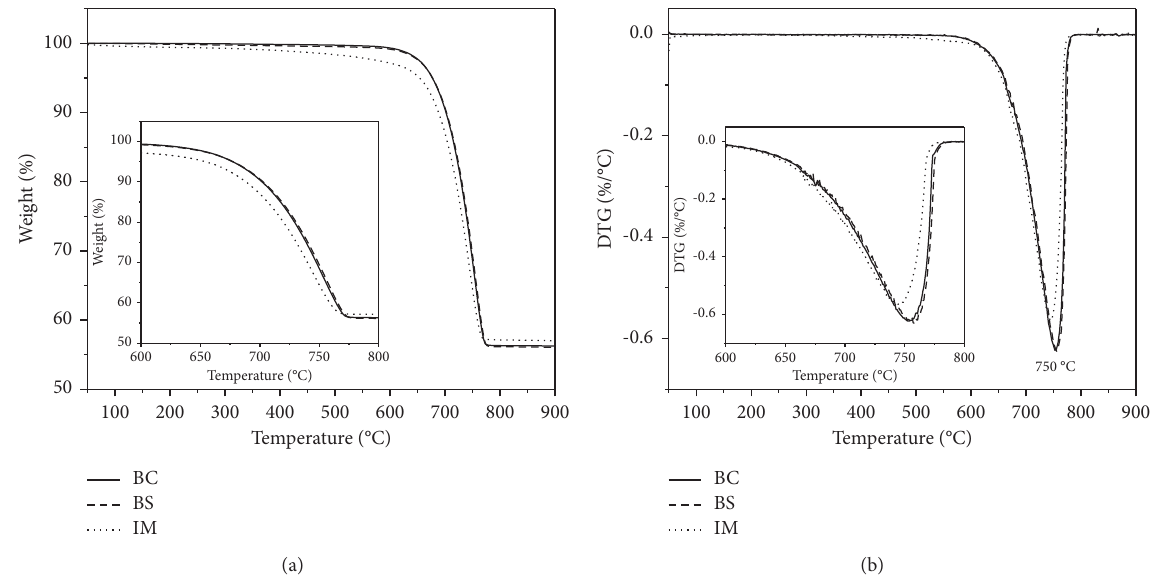
Figure 4: TGA curves of three untreated types of limestones. (a) TGA thermogram. (b) DTG curve.